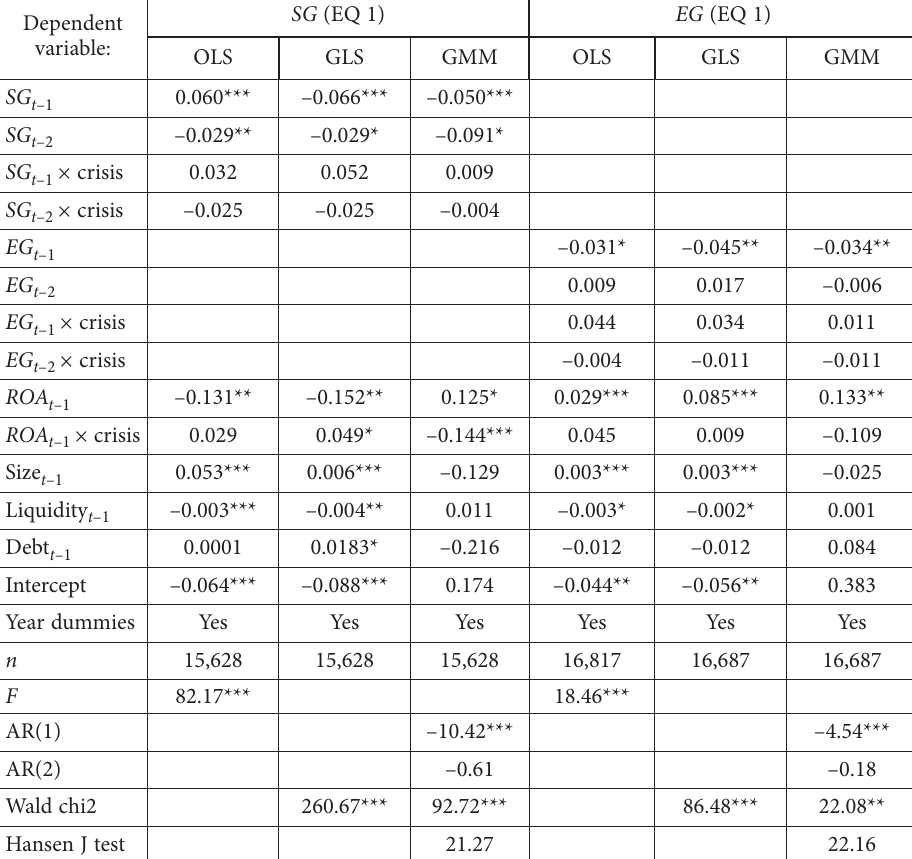
Table 4. Results of the panel estimation: growth